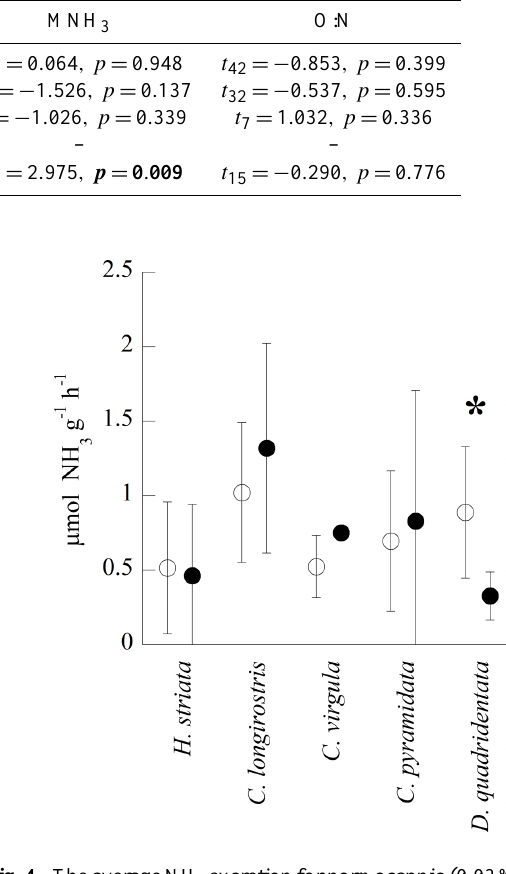
Fig. 4. The average NH 3 excretion for normocapnic (0.03%, white) and hypercapnic (0.10%, black) treatments (Table 4). Error bars represent one standard deviation from the mean. Only one data point was available for the species Creseis virgula in the hyper- capnic treatment. Diacria quadridentata was the only thecosome which responded with a significant change in NH 3 excretion